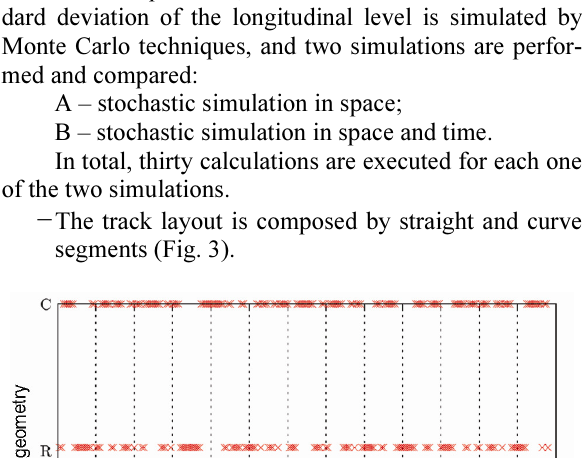
Fig. 4. Simulation A